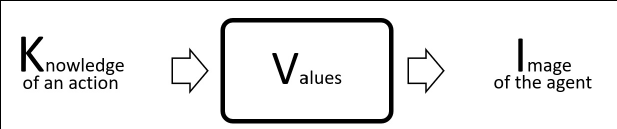
FIGURE 5 | Values as a black box: The model explains altruistic actions. The knowledge of an agent’s action is transformed into an image of the agent according to the values of a society. Such altruistic actions are evolutionarily stable if the costs of the altruistic actions are lower than the benefits of the signal that shapes the image of the